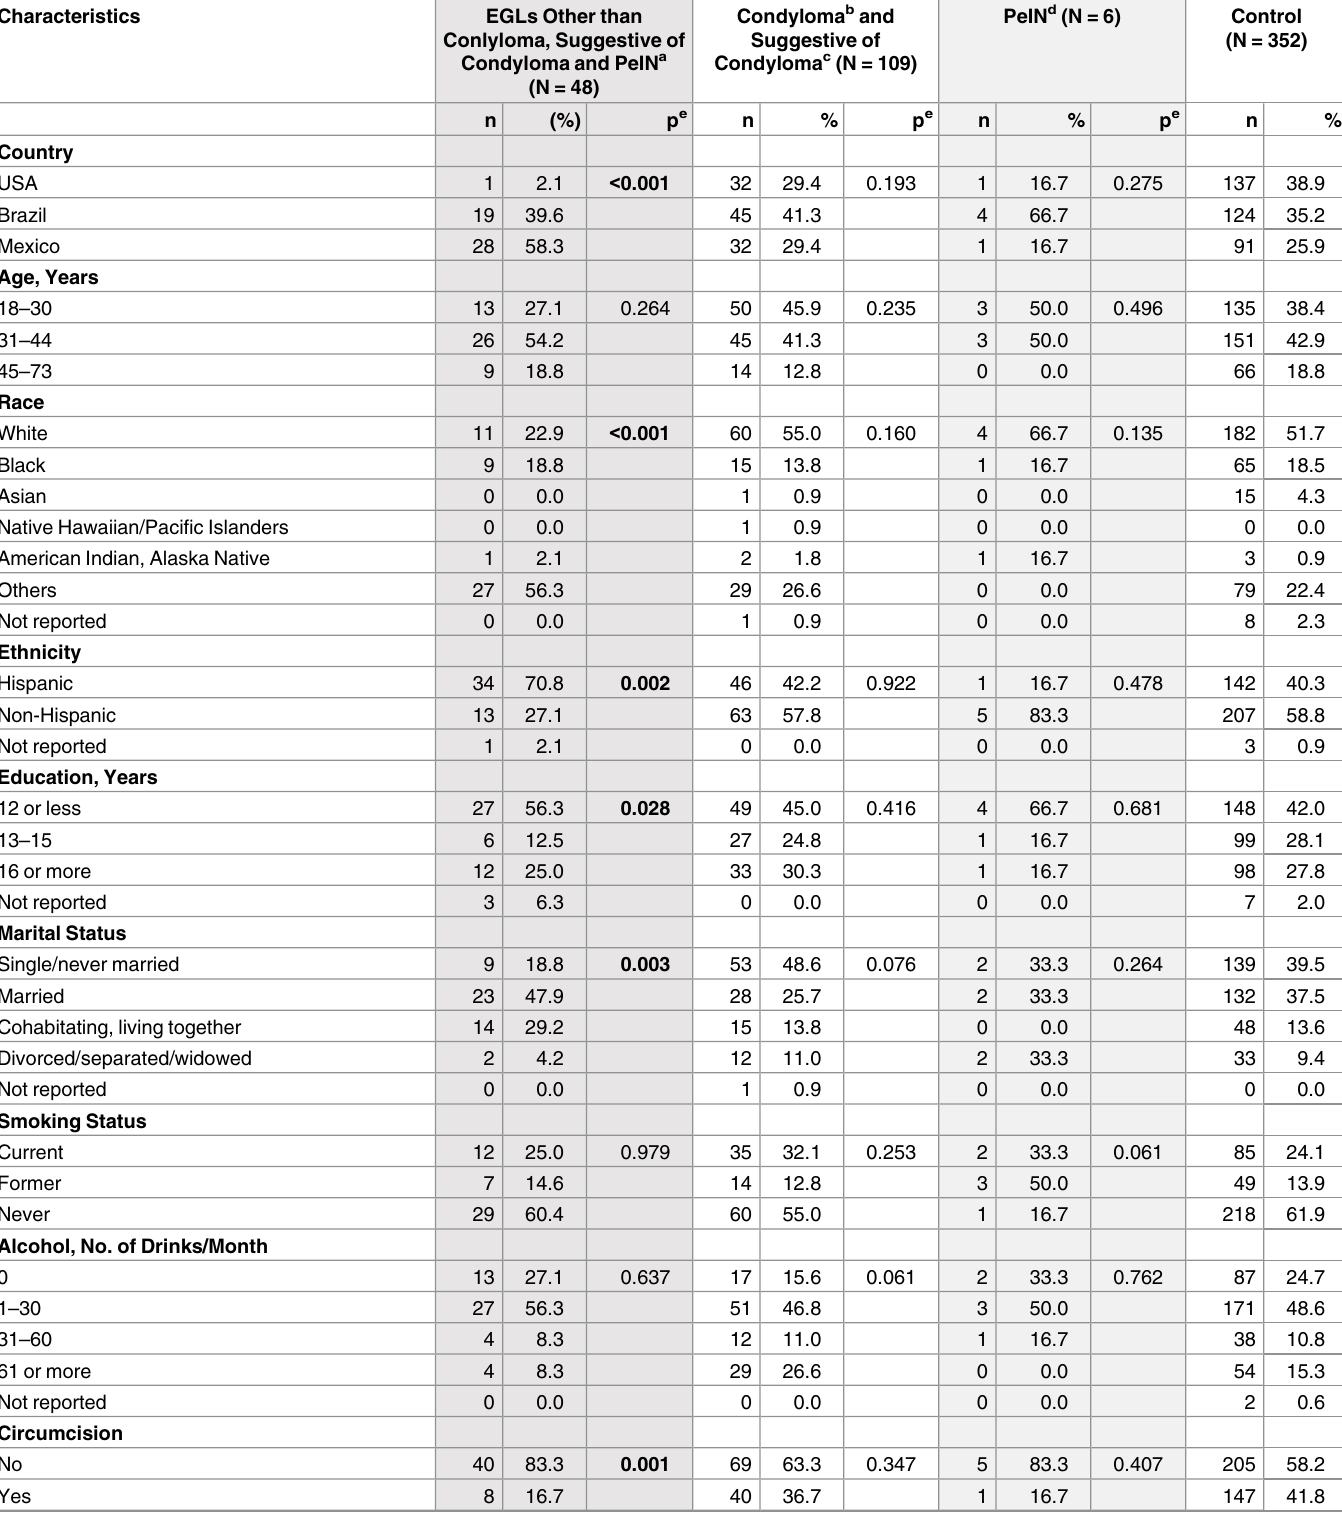
Table 1. Association between demographic, lifestyle and sexual behavior factors and external genital lesions (EGLs) and controls.